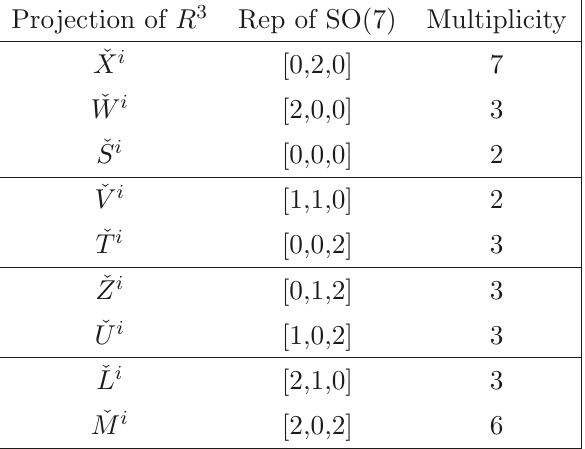
3 R in δψ . In each case, the index i runs over the corresponding ⊗